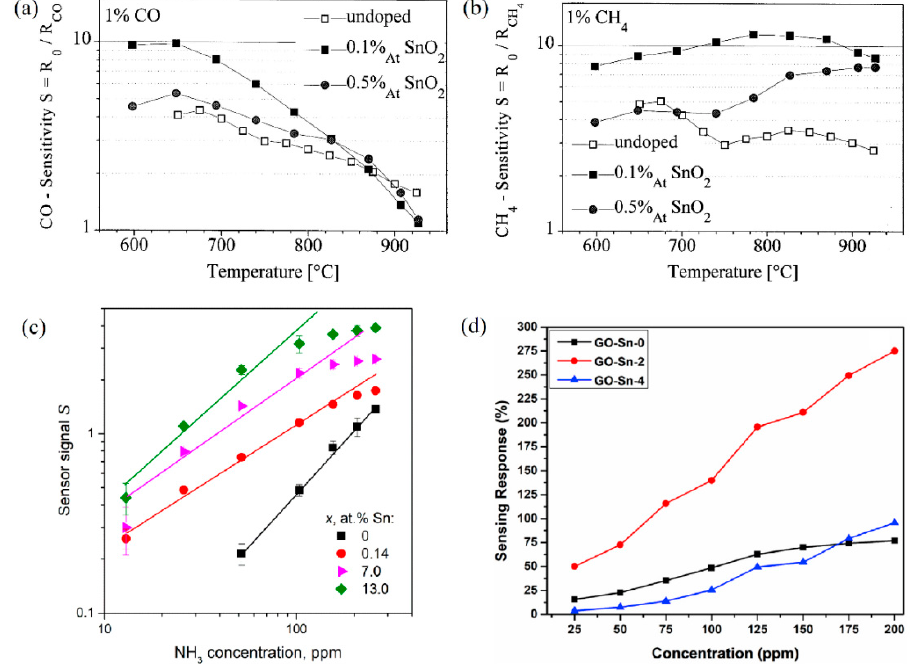
Figure 13. Enhancement of the sensitivity to ( a ) 1% CO and ( b ) 1% CH 4 of Sn ‐ doped Ga 2 O 3 thin films compared to undoped films [189]. Copyright 1998 Elsevier. ( c ) Sensor signal as a function of NH 3 concentration for Sn ‐ doped Ga 2 O 3 samples measured at 500 °C [170]. Copyright 2021 MDPI. ( d ) Room temperature ‐ sensing response as a function of NH 3 concentration [162]. Copyright 2021 Else ‐ vier.